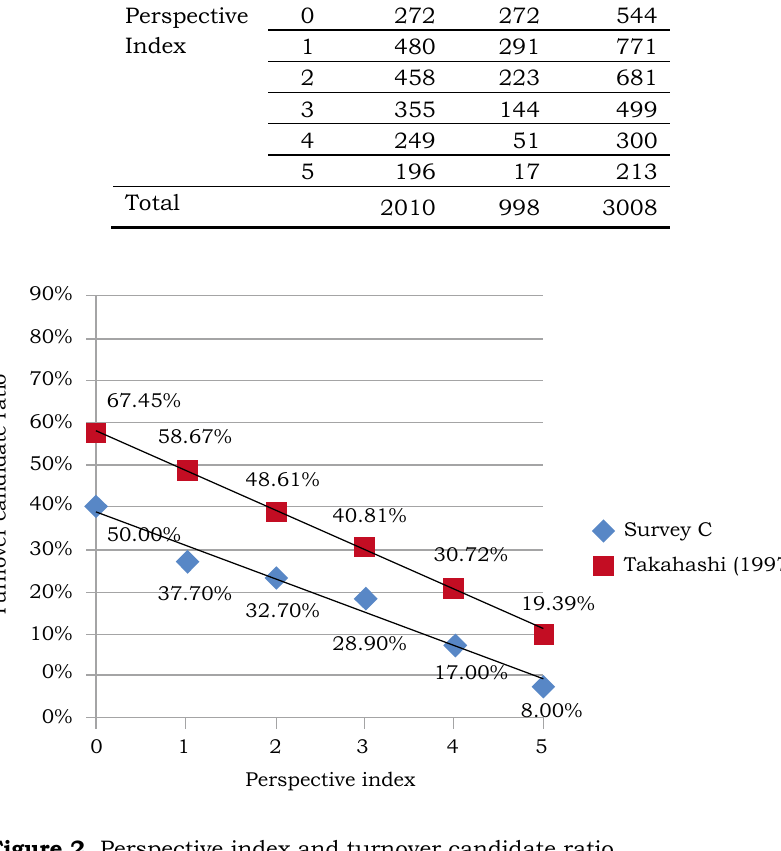
the horizontal axis. Regression analysis treating turnover candidate ratio as a dependent variable and the perspective index as an explanatory variable was performed. The regression formula used in 156